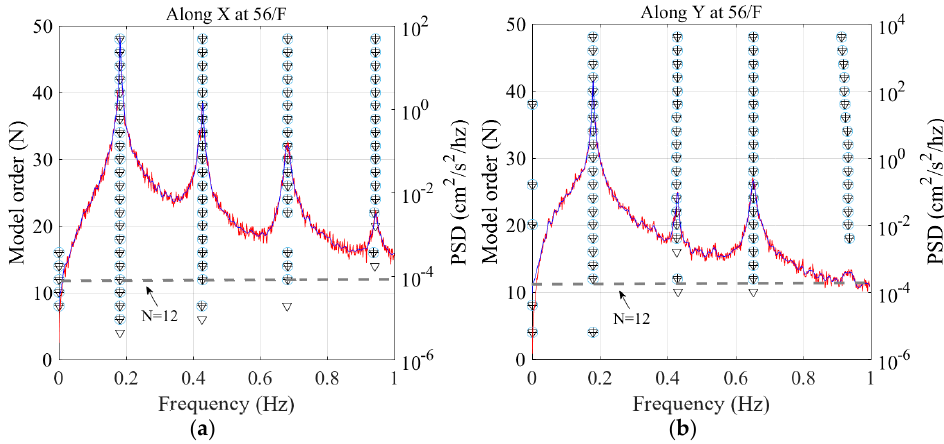
Figure 11. Stability diagram overlaid by power spectral density (PSD) results at the 56th floor. ( a ) Along X; ( b ) Along Y. Table 4. Results of damping ratio and natural frequency estimated via random decrement technique (RDT) and stochastic subspace identification (SSI).